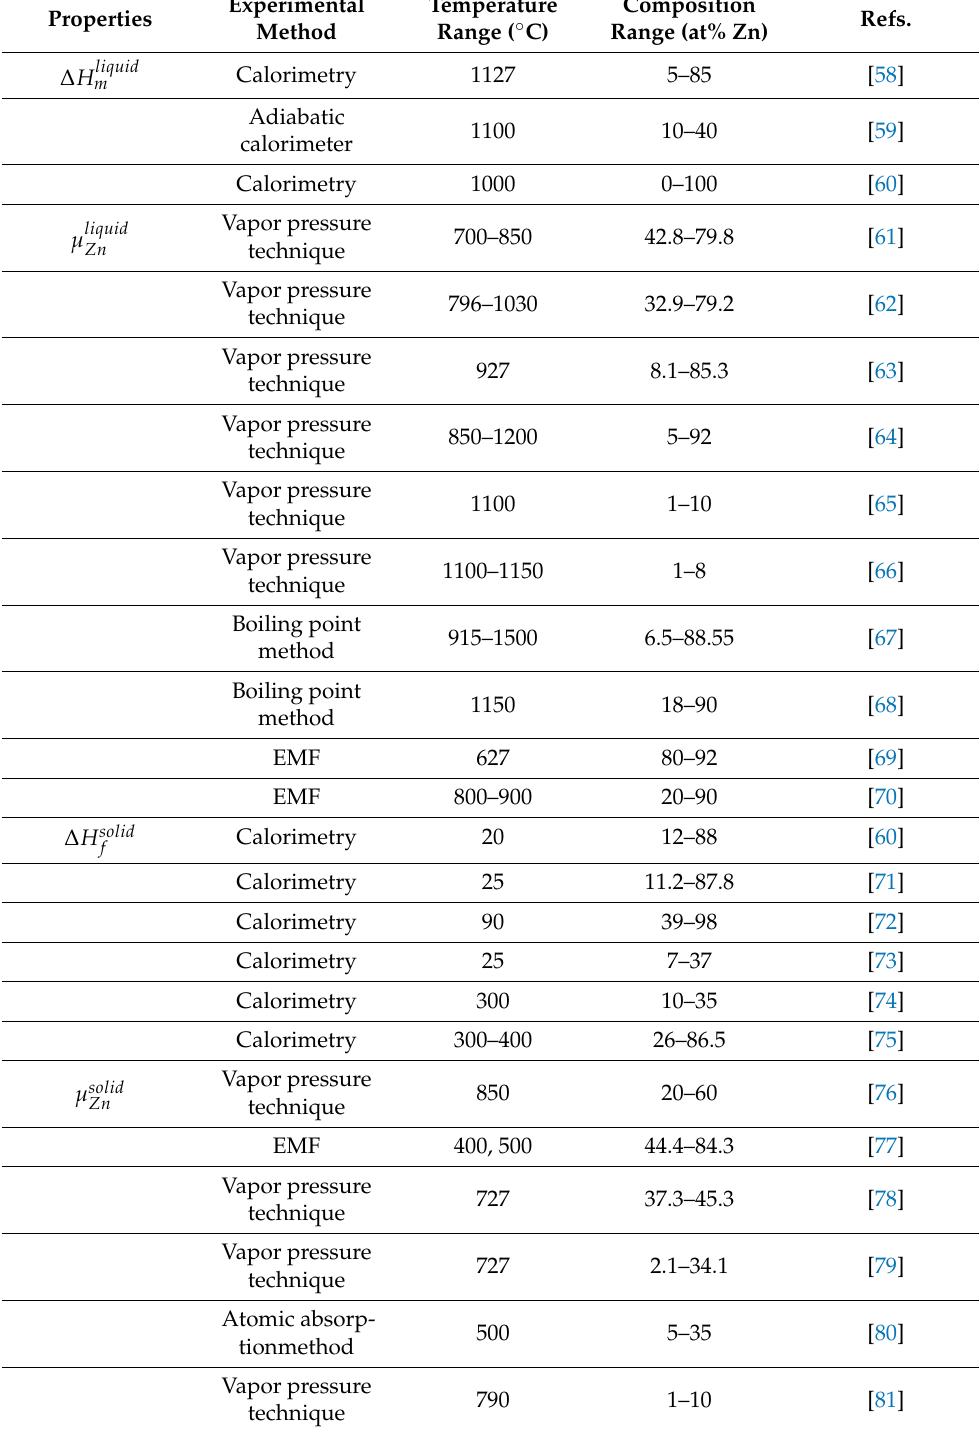
Table 1. Summary of original experimental results [58–81] on the thermodynamic properties of the Cu-Zn binary